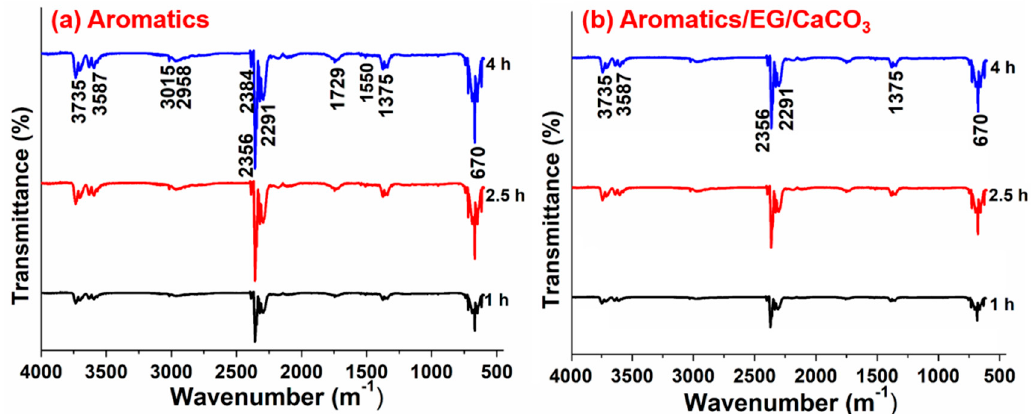
Figure 4. FTIR test results of volatiles released from ( a ) aromatics and ( b ) aromatics/EG/CaCO 3 during the isothermal-oxidative aging.